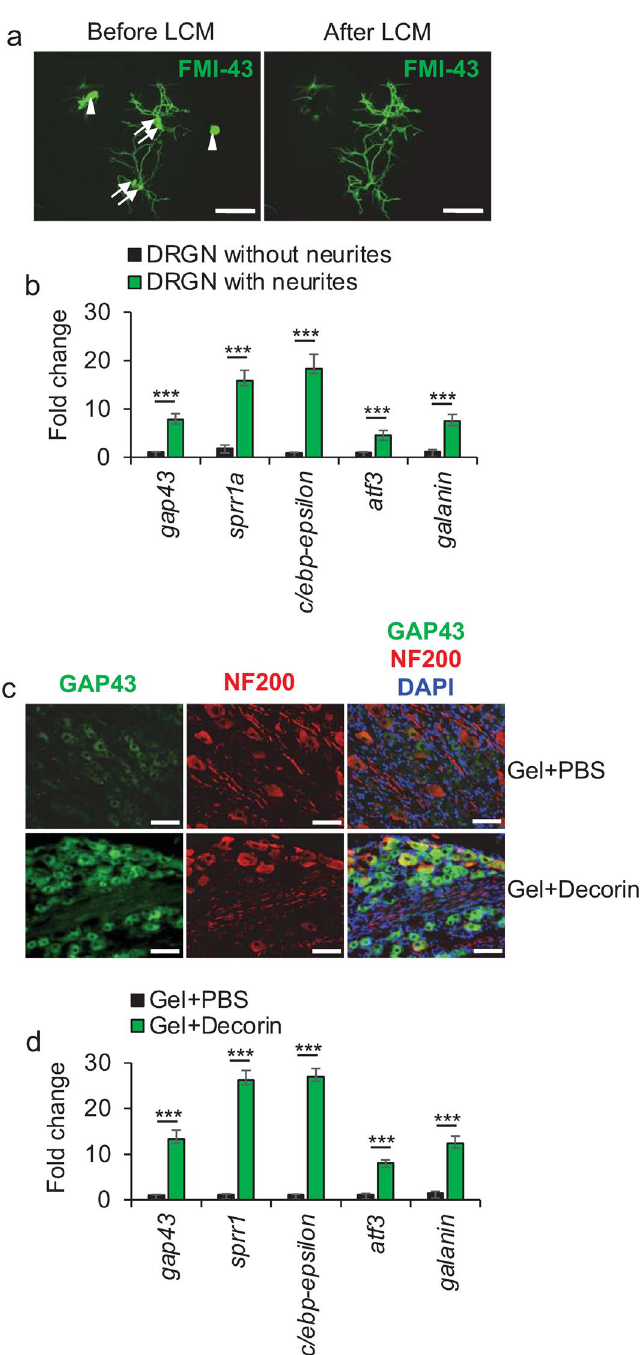
Figure 5. Regeneration associated genes (RAGs) are upregulated in DRGN in response to Decorin treatment. ( a ) LCM to show before and after LCM capture of FMI-43 + DRGN cell bodies with (arrows) and without (arrowheads) neurites. (b ) RAG mRNA expression was significantly higher in DRGN with neurites compared to those without neurites after exposure to Decorin. n = 1000 DRGN/treatment, 6 independent repeats (total n = 6000 DRGN/treatment group). ( c ) GAP43 immunohistochemistry to show enhanced levels of GAP43 + immunoreactivity in DRGN at 10 days after DC injury and treatment. ( d ) Fold change in RAG mRNA expression levels in L4/L5 dorsal root ganglia (DRG) bundles after Gel + PBS and Gel + Decorin treatment (normalised to mRNA levels in PBS treated wounds). n = 8 rats/treatment. Scale bars in ( a ) = 100 µm and ( c ) 25 µm. *** P < 0.0001, one-way ANOVA with Dunnett’s post hoc